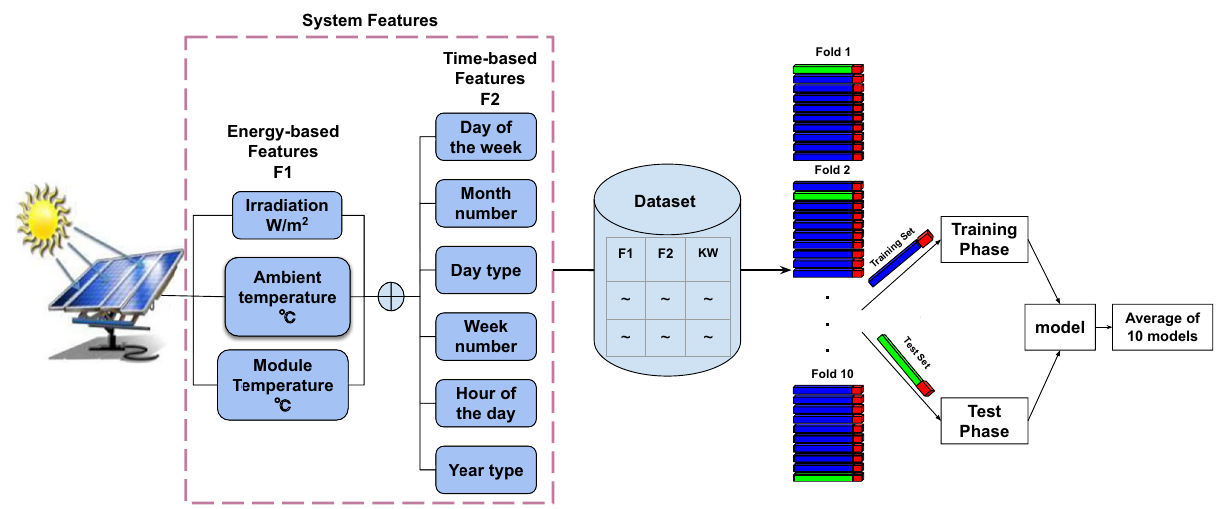
Figure 3: The architecture of the proposed